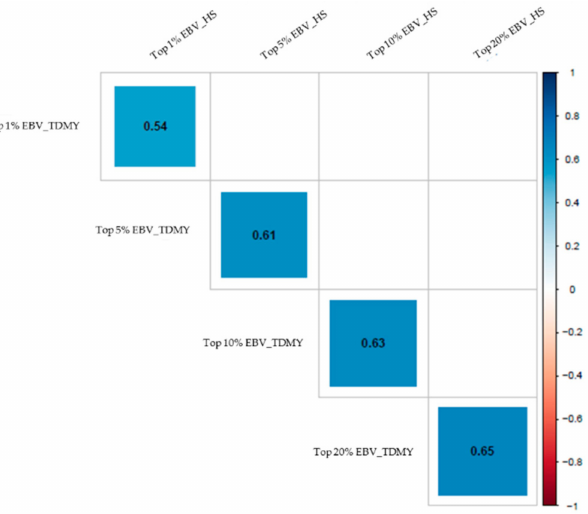
Figure 7. Spearman rank correlation coefficients for top 1%, top 5%, top 10% and top 20% best sires (estimated breeding values—EBVs) regarding test-day milk yield (TDMY) and heat stress (HS), according to model 4 (M4) using Legendre polynomials. The colors inside the squares indicate the magnitudes and directions of the associations.